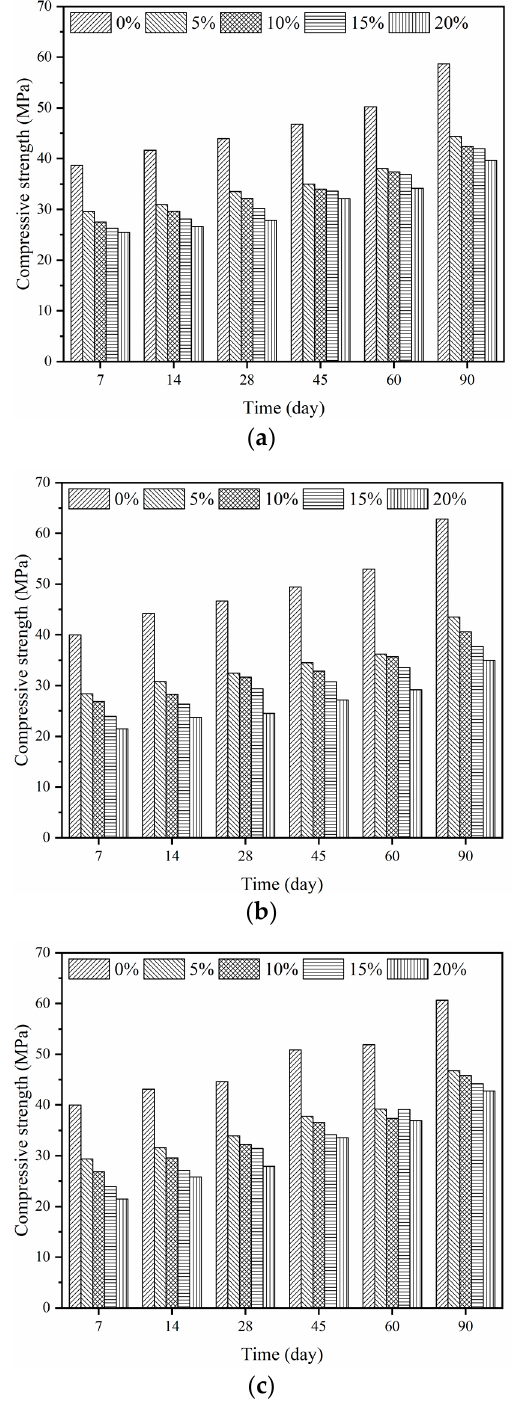
Figure 3. Compressive strength of epoxy latexes modified mortar: ( a ) dry curing, ( b ) wet curing, and ( c ) wet–dry curing .